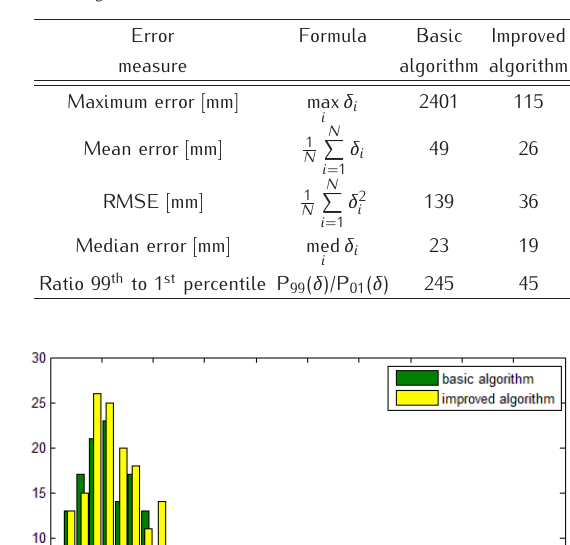
Table 1. Comparisonofstatisticalmeasuresforerrorsofthebasicandimproved algorithms, for all test series.